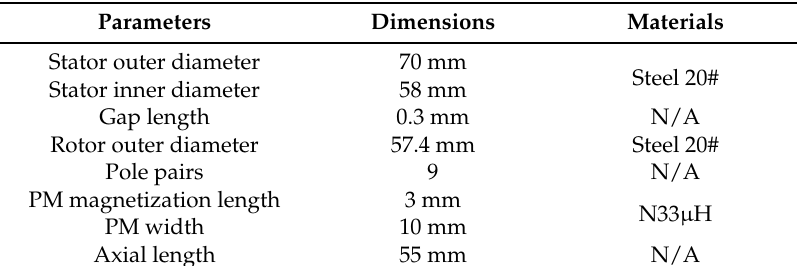
Table 1. Parameters of the prototype.